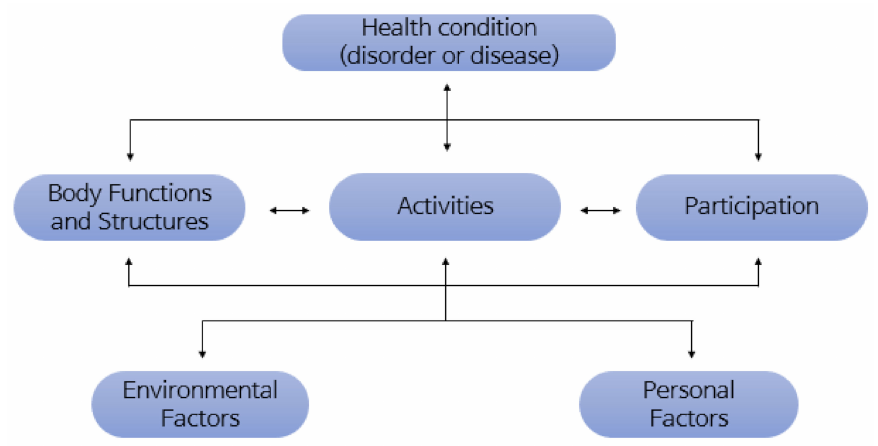
Figure 1. Concept of the